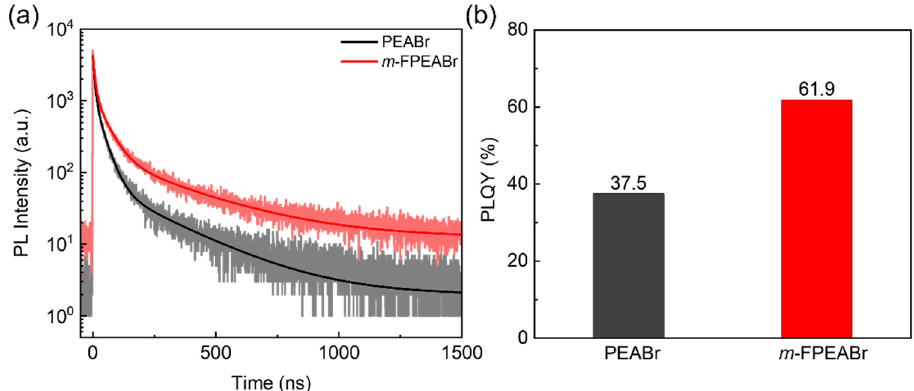
Figure 8. ( a ) TRPL spectra and ( b ) PLQYs of PEABr and m -FPEABr perovskite